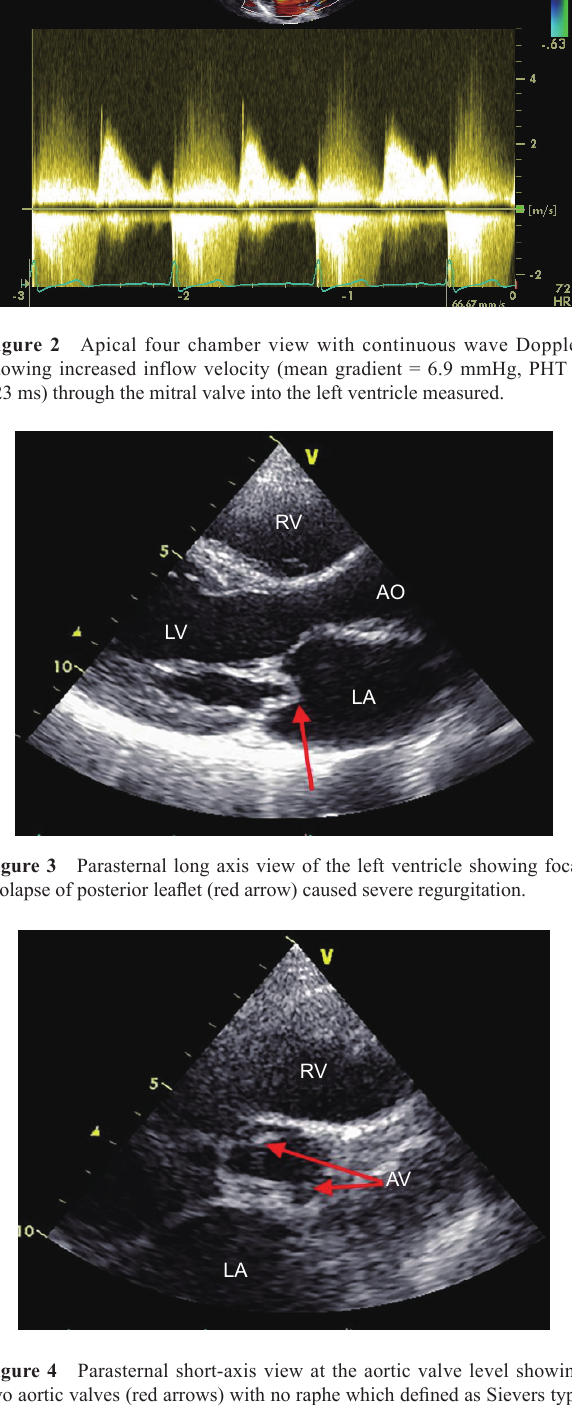
Figure 4 Parasternal short-axis view at the aortic valve level showing two aortic valves (red arrows) with no raphe which defined as Sievers type 0 morphology.